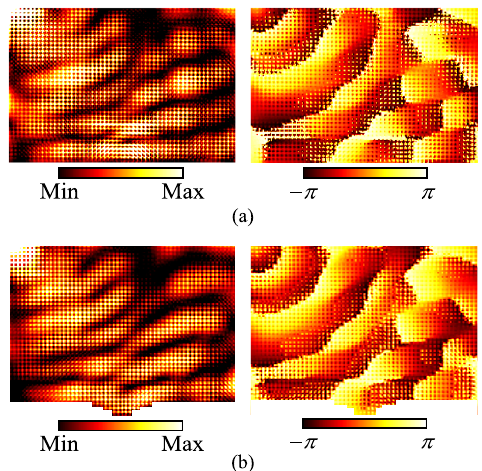
Fig. 24. Measured complex electric near- fi eld distributions with a point source at the top corner (Position B in Fig. 19) at 4.65 GHz. Left: Amplitude. Right: Phase. (a) With the groove illusion medium. (b) With the original groove.